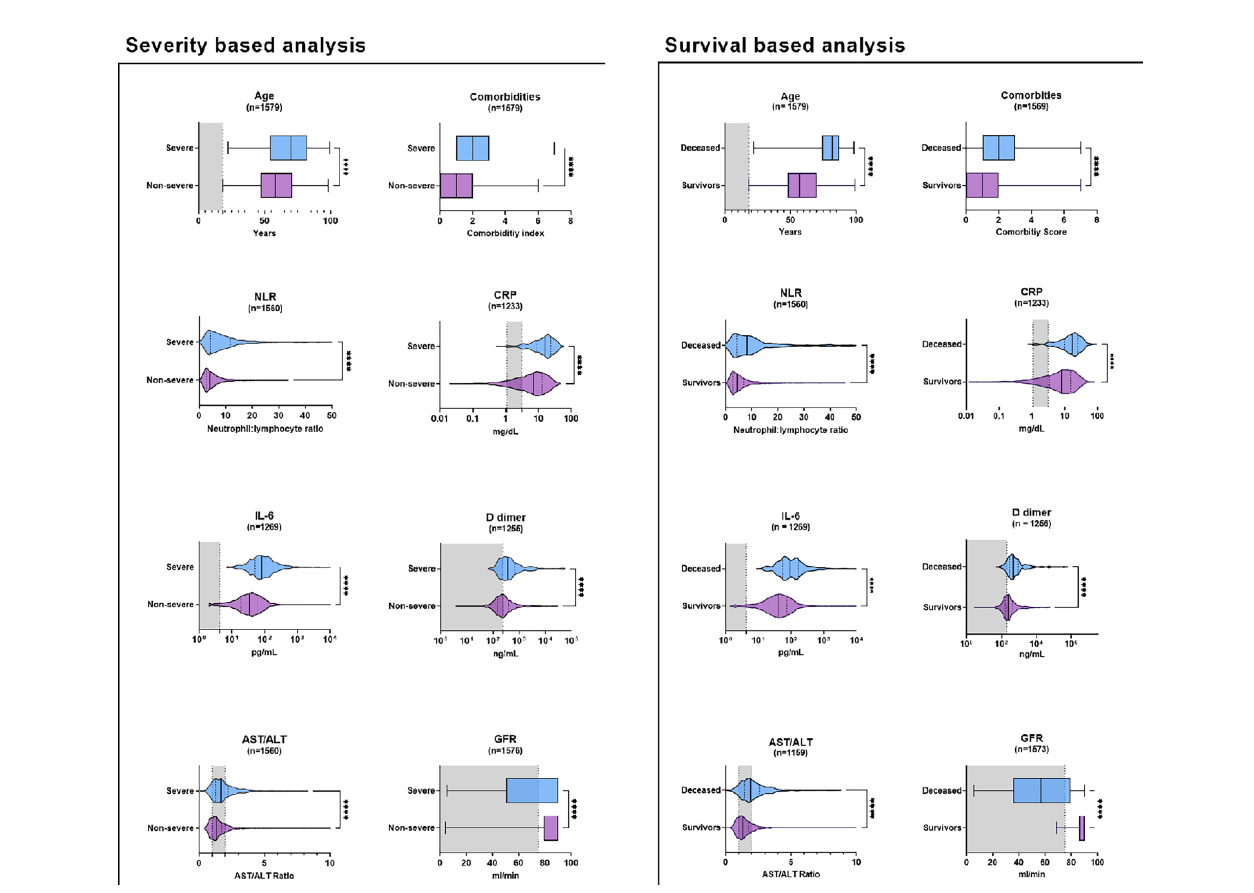
FIGURE 3 | Univariate comparisons of a selection of clinical laboratory-derived variables at admission and 28-days survival for the survival/decease and non-severe, severe outcomes in the Vall d ’ Hebron University Hospital cohort. n, number of cases plotted; NLR, neutrophil-to-lymphocyte ratio; CRP, C-reactive protein; AST, aspartate aminotransferase; ALT, alanine aminotransferase; GFR, glomerular fi ltration rate. ****p < 0.0001. When non-signi fi cant, the numerical p-values are given. The exact p-values are given in Table 2 . The distribution of age and GFR are markedly different in both the severity and survival